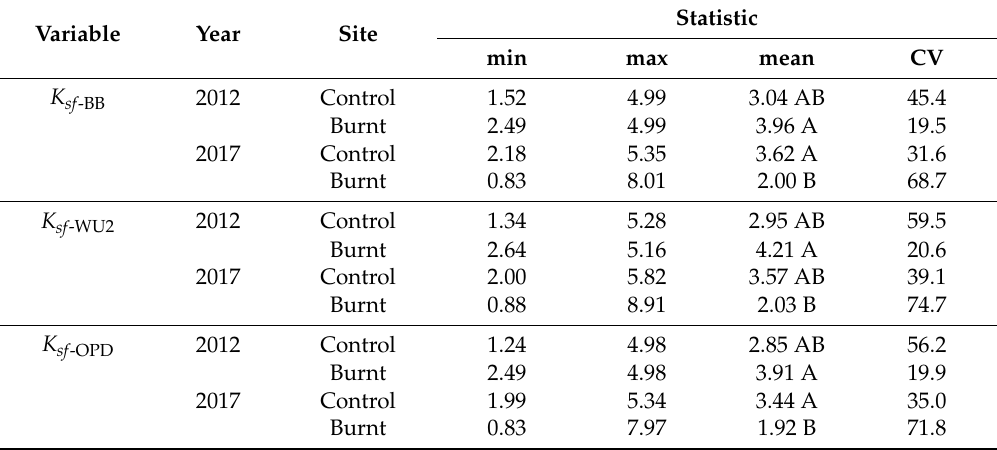
Table 4. Summary of the field-saturated hydraulic conductivity, K fs (mm · h − 1 ), data sets obtained by the BB, WU2, and OPD methods. Sample size, N = 10 for each site and sampling campaign.